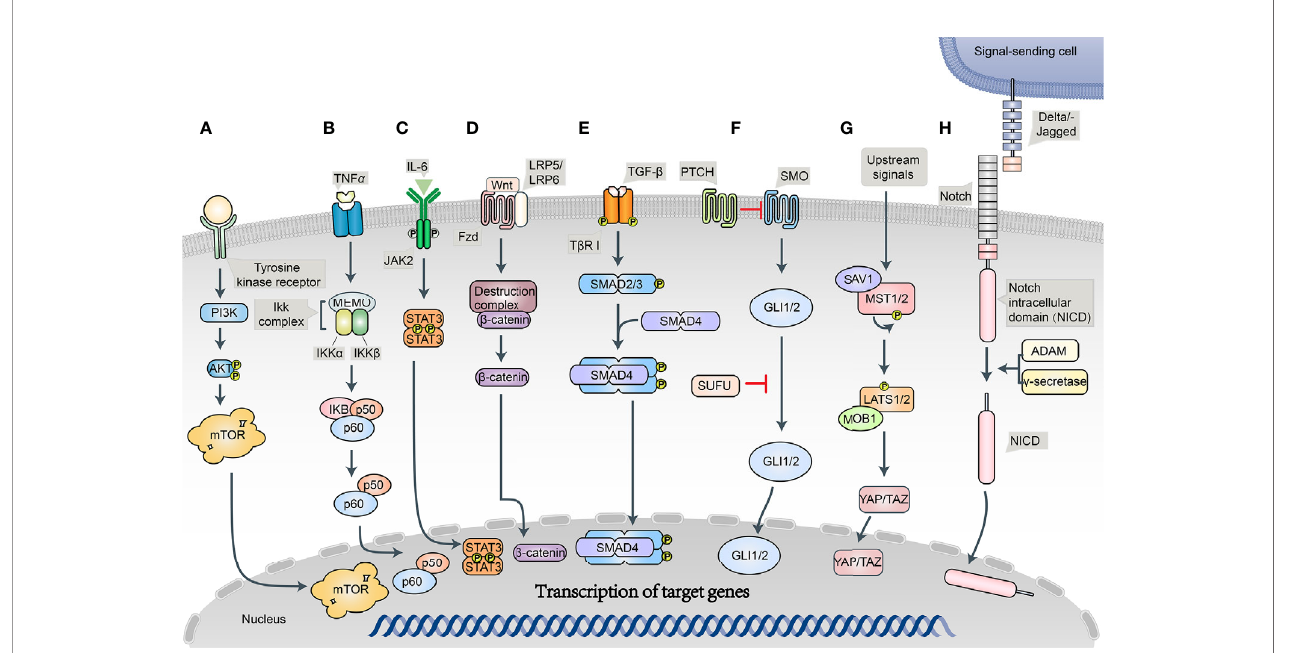
FIGURE 2 | Schematic diagram of the BC signaling pathways. (A) PI3K/Akt/mTOR signaling pathway; (B) NF- k B signaling pathway; (C) JAK/STAT signaling pathway; (D) Wnt/Frizzled/ b -catenin signaling pathway; (E) Notch signaling pathway; (F) Hedgehog (Hh) signaling pathway; (G) Hippo signaling pathway; (H) TGF- b signaling